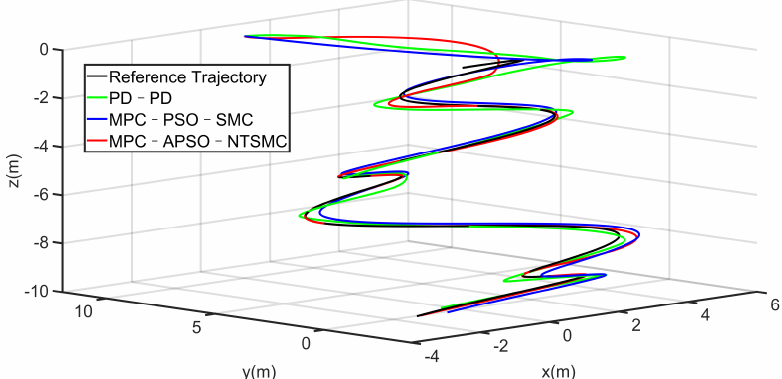
Figure 29. AUV complex curve trajectory tracking with wave and current disturbance for Case 2.